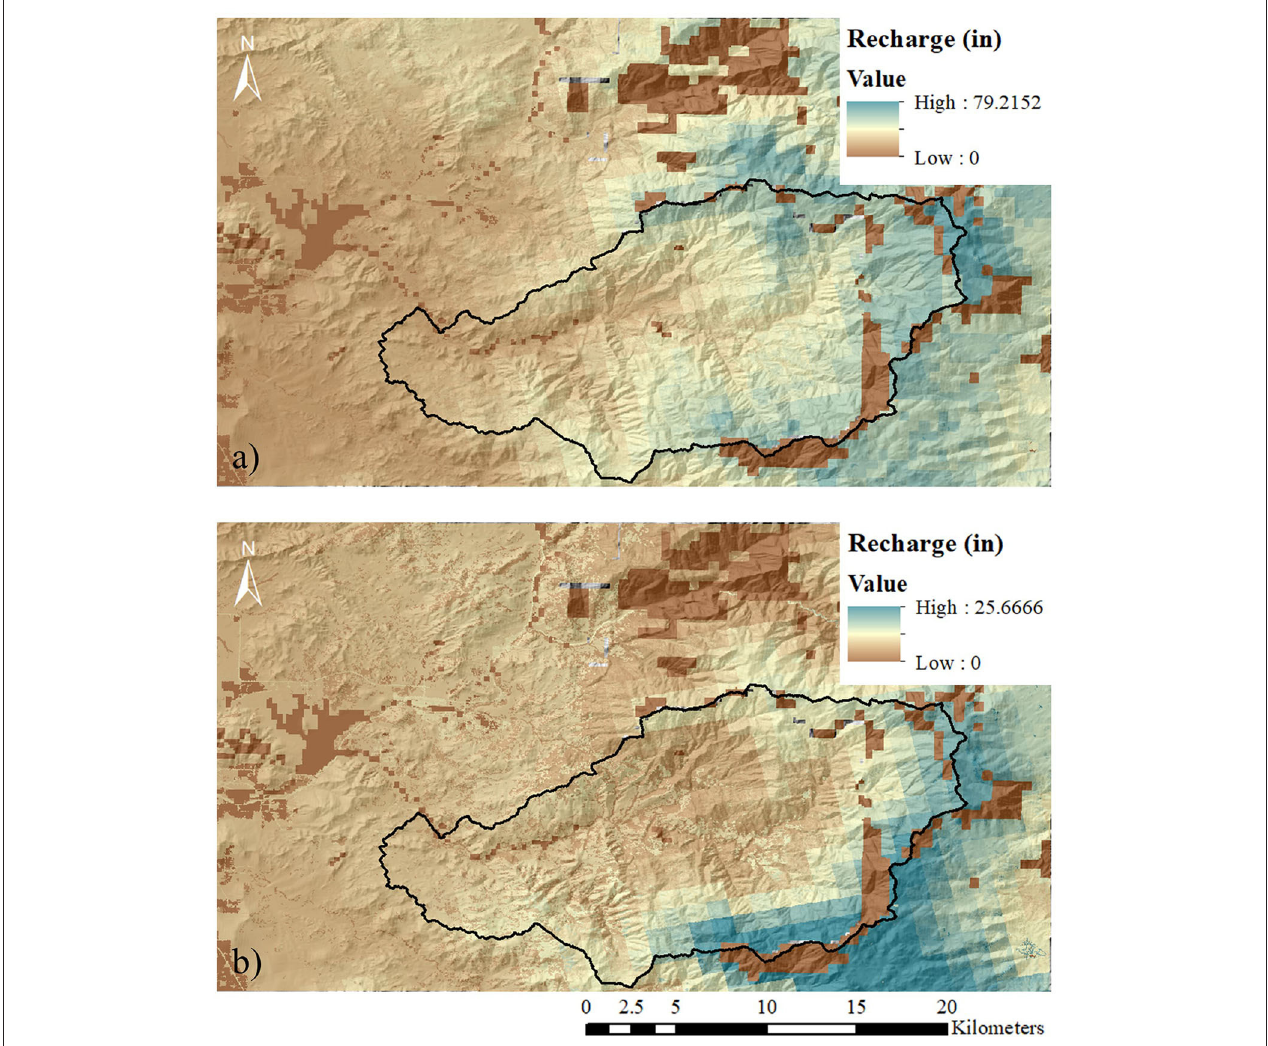
FIGURE 6 | (a) Potential recharge distribution across model domain in highest recharge year 1983. (b) potential recharge distribution across model domain in lowest recharge year 2013. Calibration watershed outlined in black.